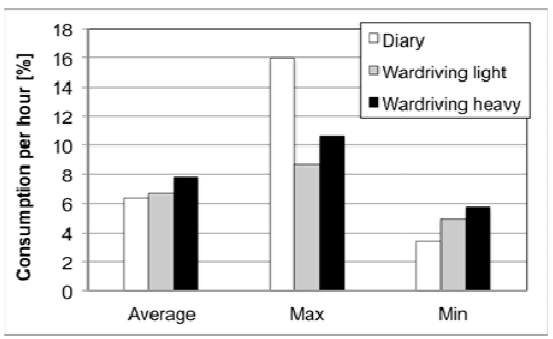
Figure 4 . Battery consumption in various